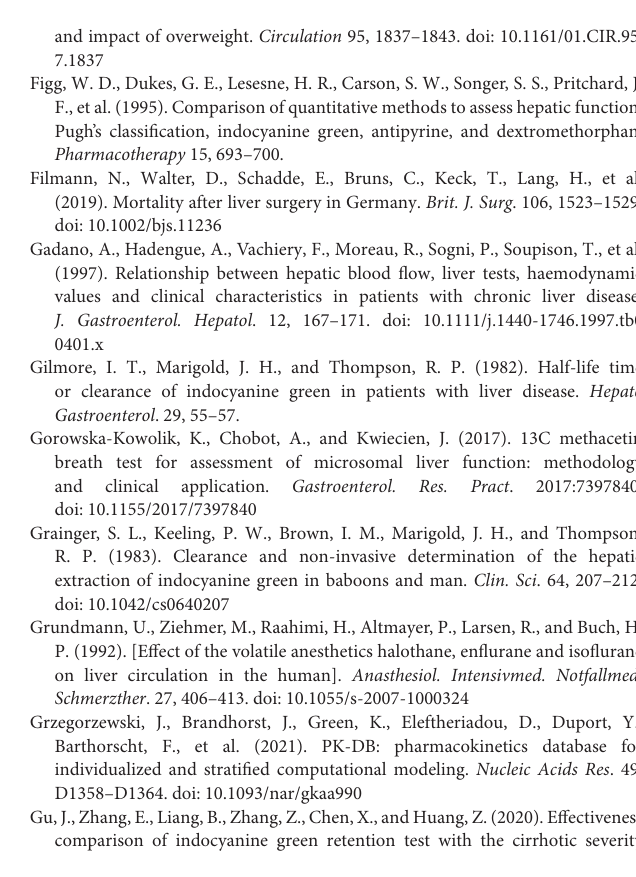
Frontiers in Physiology |